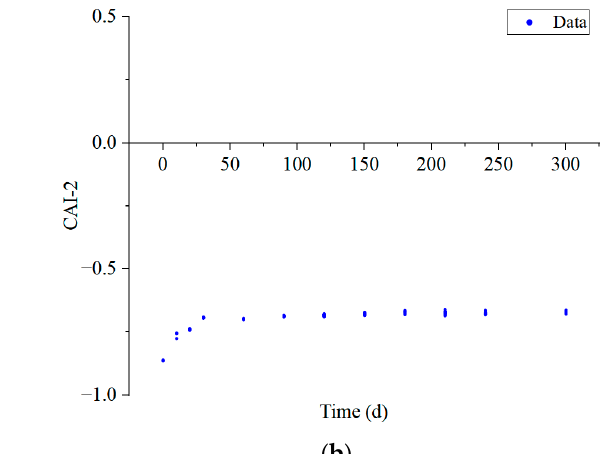
Table 3. Results of inverse geochemical modeling.